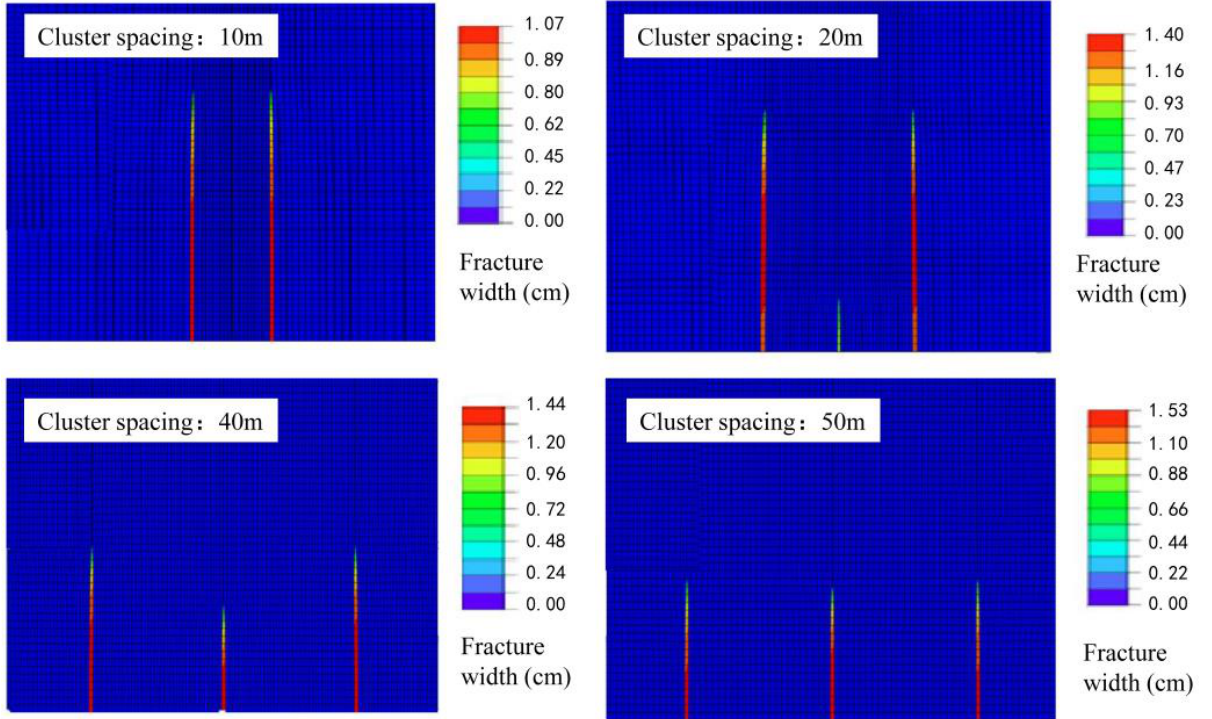
Figure 3: Contour of fracture morphology after fracturing for 10 minutes when the cluster spacing is different. (Deformation scale factor =